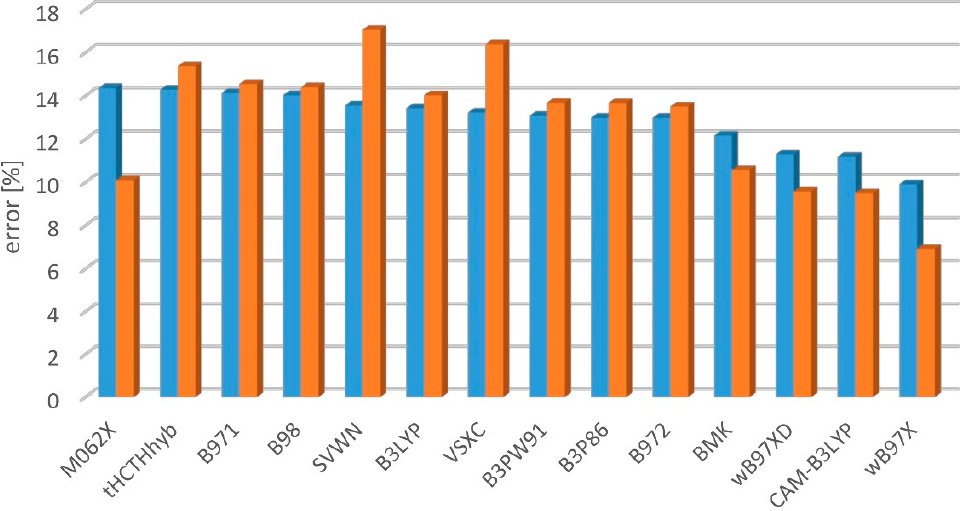
Figure 4. Mean absolute percent error of TD-DFT/aug-cc-pVTZ-derived singlet-singlet excitation energy predictions, with respect to the experimental gas-phase (blue) or Kr-matrix (orange) values.